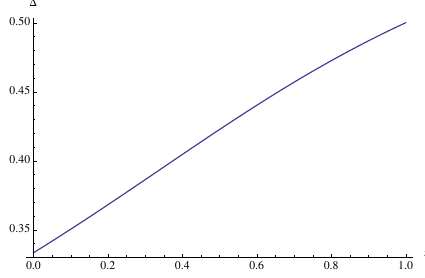
Figure 13 . Representation of the R-charge ∆ with respect to the ratio p/q for L pqp models. Both q and p are positive integers, with 0 < p < q , i.e. 0 < p/q < 1 . The physical R-charges correspond to the ones when the ratio p/q is a rational number between 0 and 1 in the